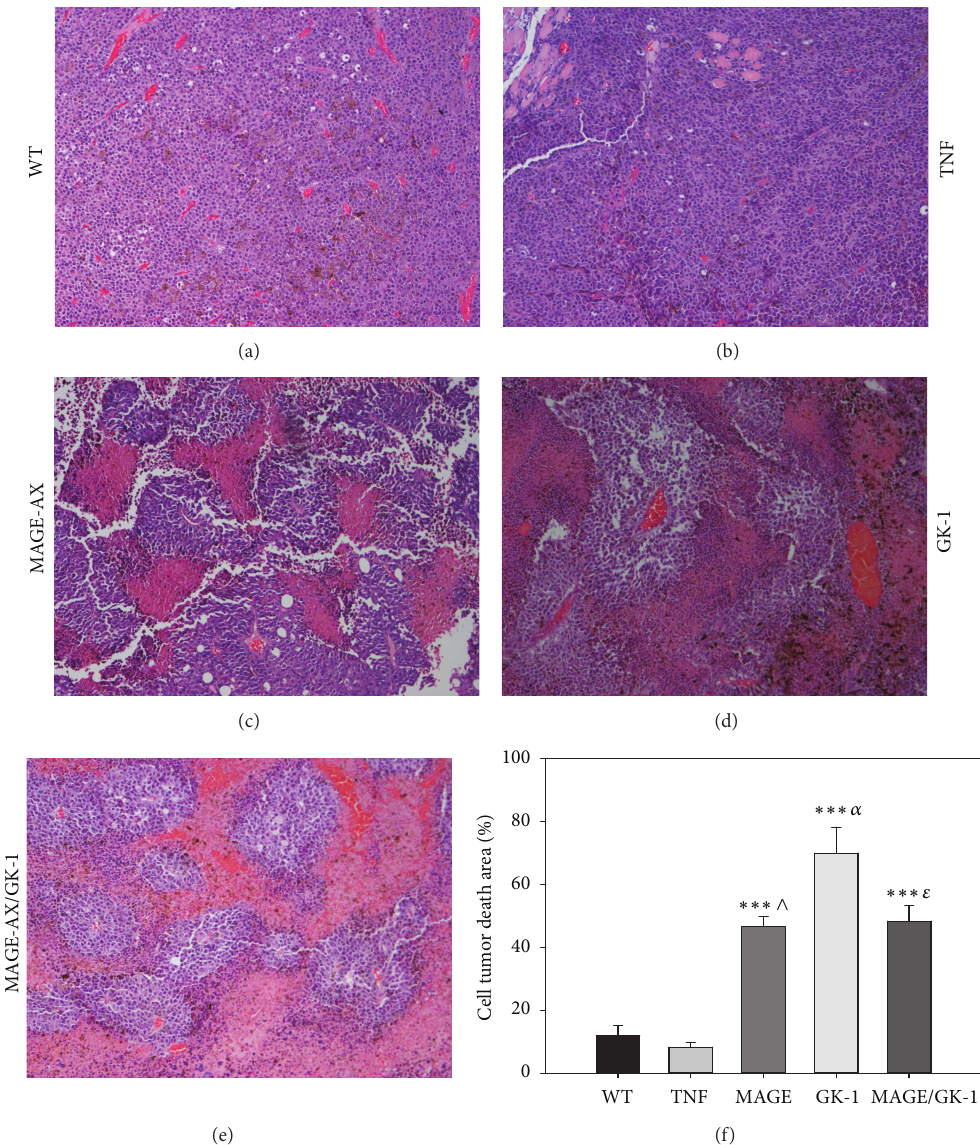
Figure 6: Histopathological analysis. Photomicrographs of histological sections of tumors from mice vaccinated with BMDCs matured with TNF 𝛼 and treated with MAGE-AX, GK-1, or MAGE-AX/GK-1. Groups MAGE-AX, GK-1, and MAGE-AX/GK-1 showed plentiful tumor cell death areas. (a) No treatment (WT). Abundant tumor cells and blood vessels were observed. (b) TNF 𝛼 . The same characteristics as those observed in untreated mice were observed: abundant tumor cells and blood vessels. (c) MAGE-AX. (d) GK-1. (e) MAGE-AX/GK-1. In (c), (d), and (e), pink areas (eosinophilic), composed of dead cells, were observed in addition to purple areas (basophilic), composed of very active tumor cells. (f) A graph showing the change in the areas of cell death in tumors from mice that were treated with BMDCs and which were stimulated with TNF 𝛼 , MAGE-AX, GK-1, or MAGE-AX/GK-1. ∗∗∗ 𝑃 < 0.001 , ∧ 𝑃 < 0.001 MAGE versus TNF, 𝛼 𝑃 < 0.0001 GK-1 versus TNF 𝛼 , 𝜀 𝑃 < 0.001 MAGE/GK-1 versus TNF. Mean ± SEM 𝑛 ≥ 3